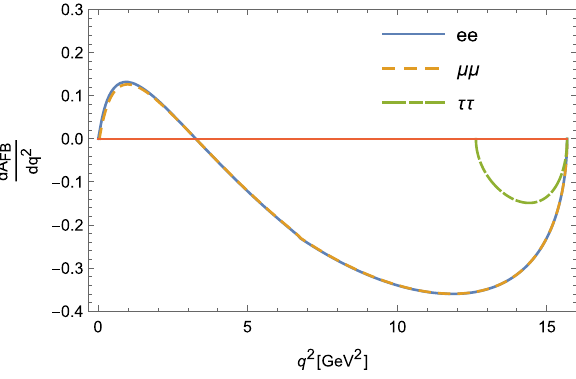
Fig. 6 The FBAs of lepton as functions of q 2 for the decays B − → ( 1320 ) l − l + ( l = e ,μ,τ) a − 2